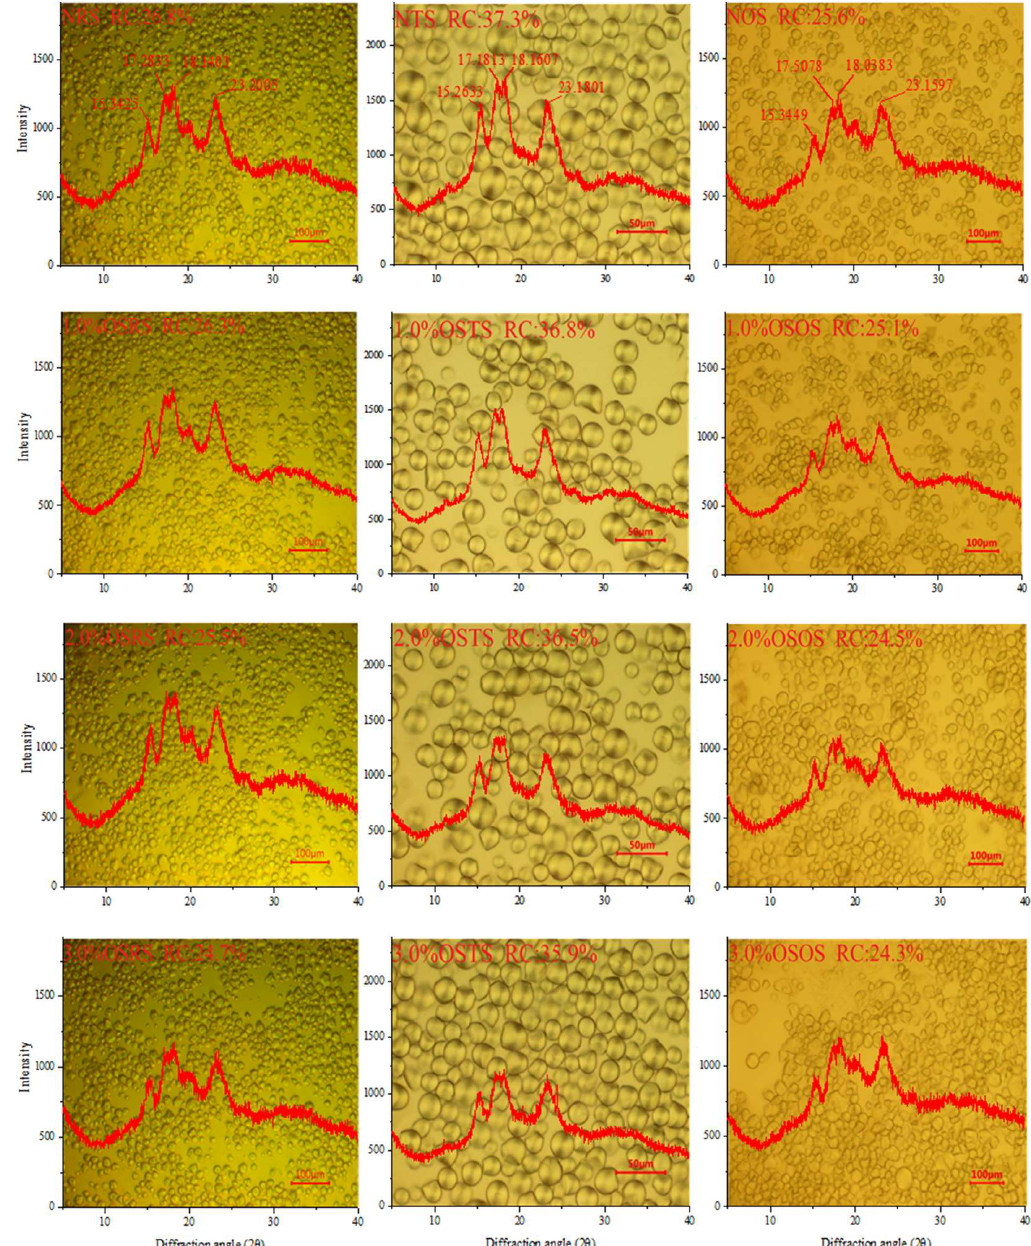
Figure 5. PLM and XRD of NS and OS-starch.